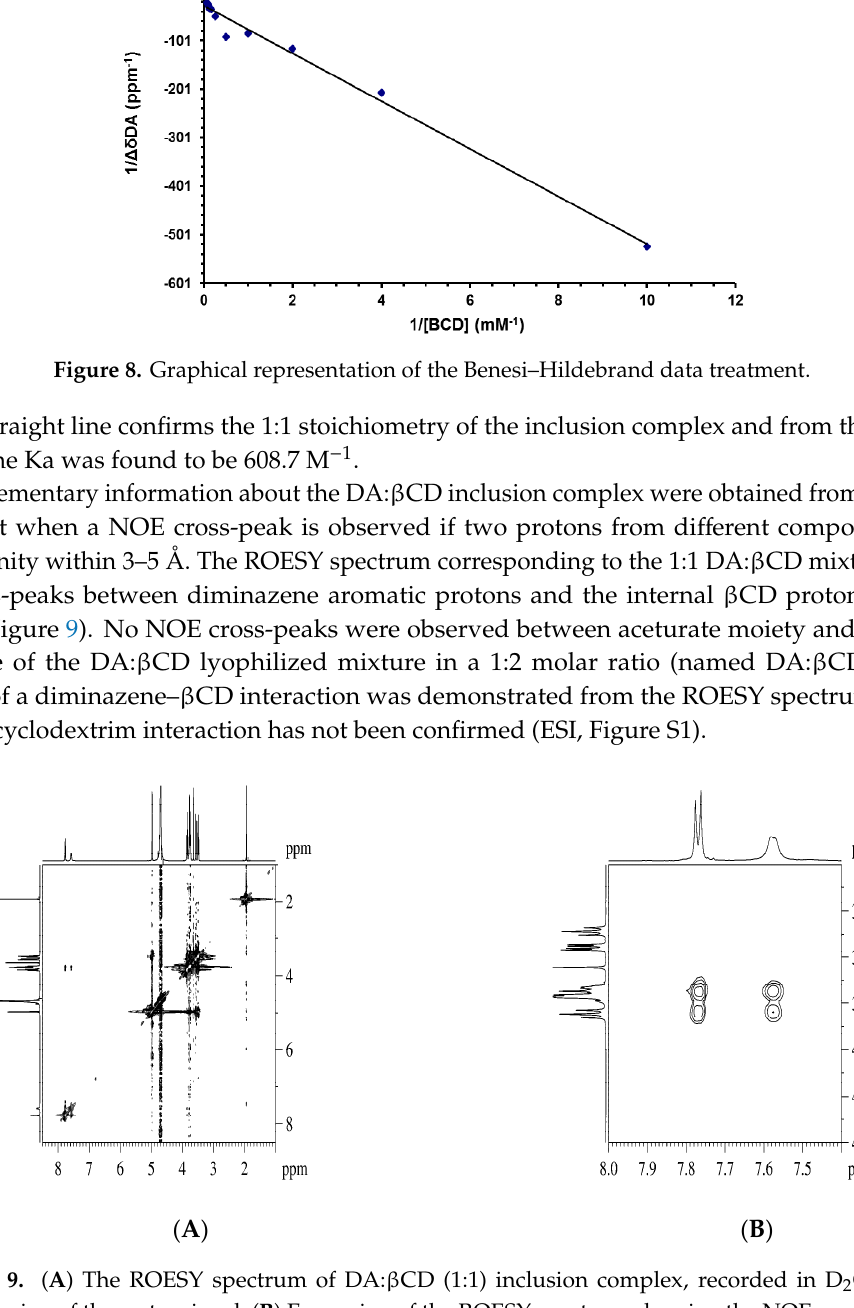
Figure 8. Graphical representation of the Benesi–Hildebrand data treatment.